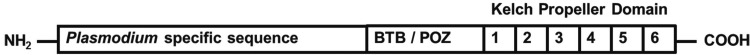
Structure of the Plasmodium sp. kelch gene.